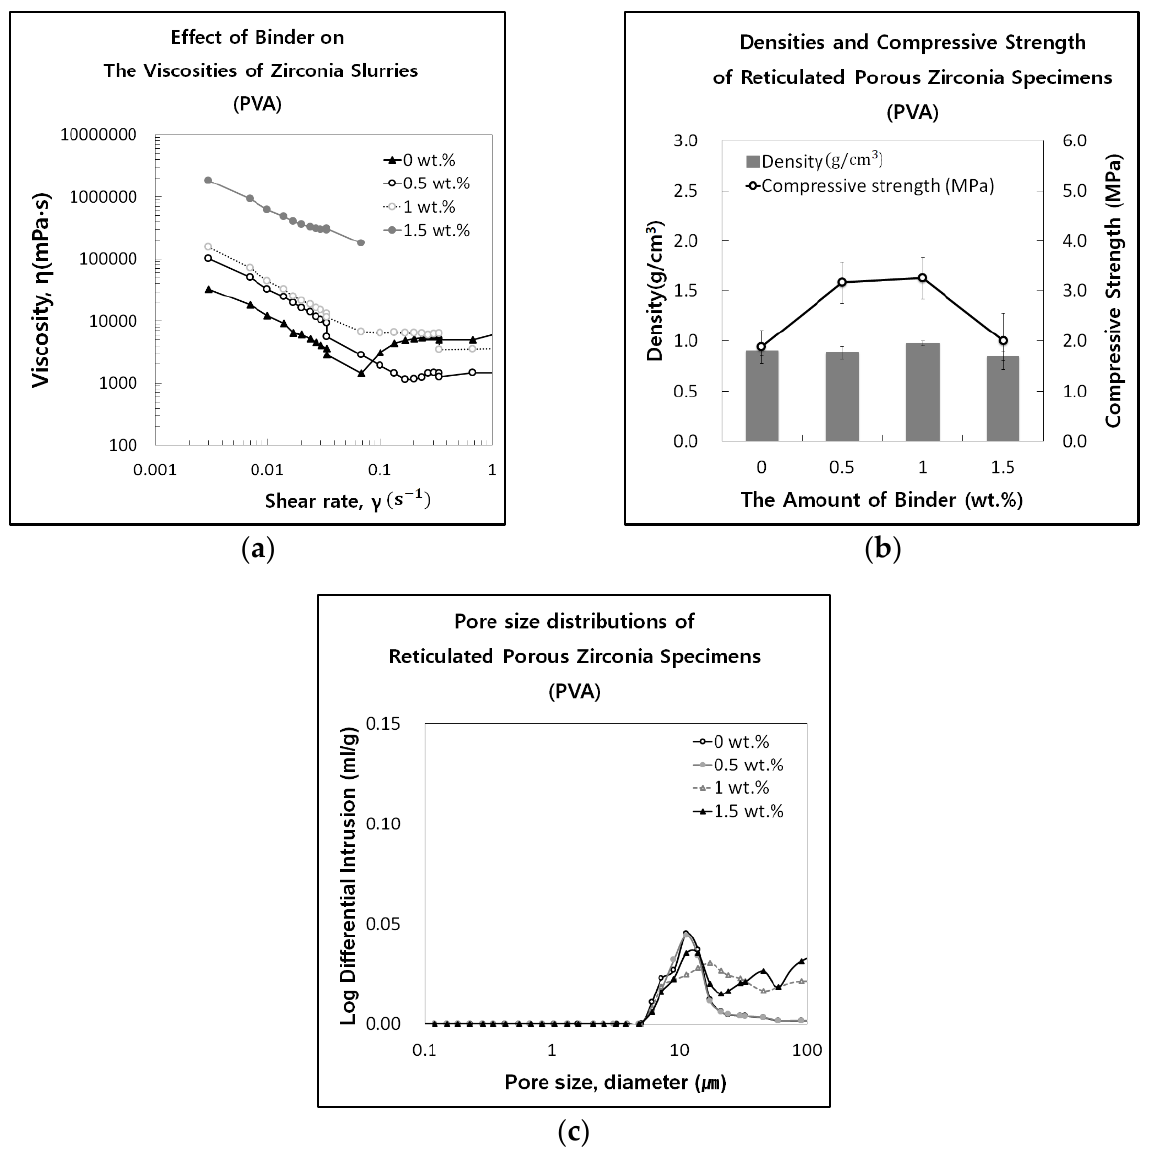
Figure 6. Effects of the addition of a binder (0 – 1.5 wt.% PVA) on the ( a ) viscosities, ( b ) densities and compressive strength, and the ( c ) pore size distribution of reticulated porous zirconia specimens.